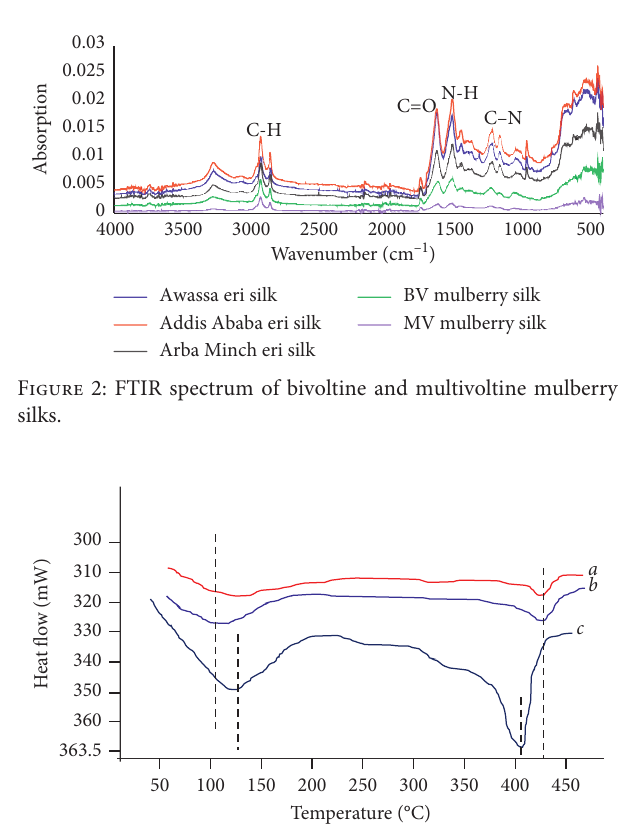
Figure 3: DSC thermograms of eri silk fibres: (a) Awassa, (b) Addis Ababa, and (c) Arba Minch.